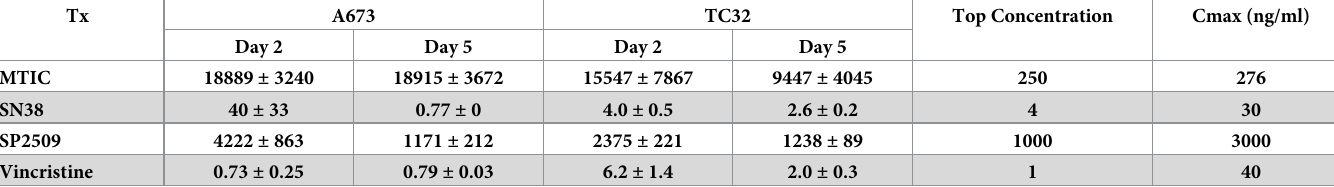
Table 3. Single agent dose response IC 50 s at 24-hours and 96-hours after treatment, ± standard error of the